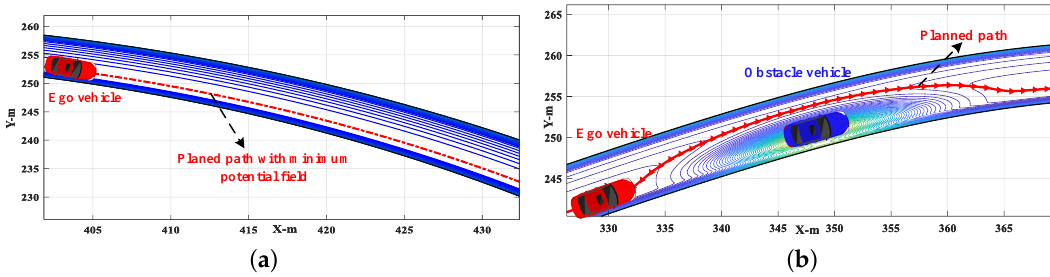
Figure 2. Examples without trapping into local minima: ( a ) scenario without obstacle vehicle; ( b ) scenario with an obstacle